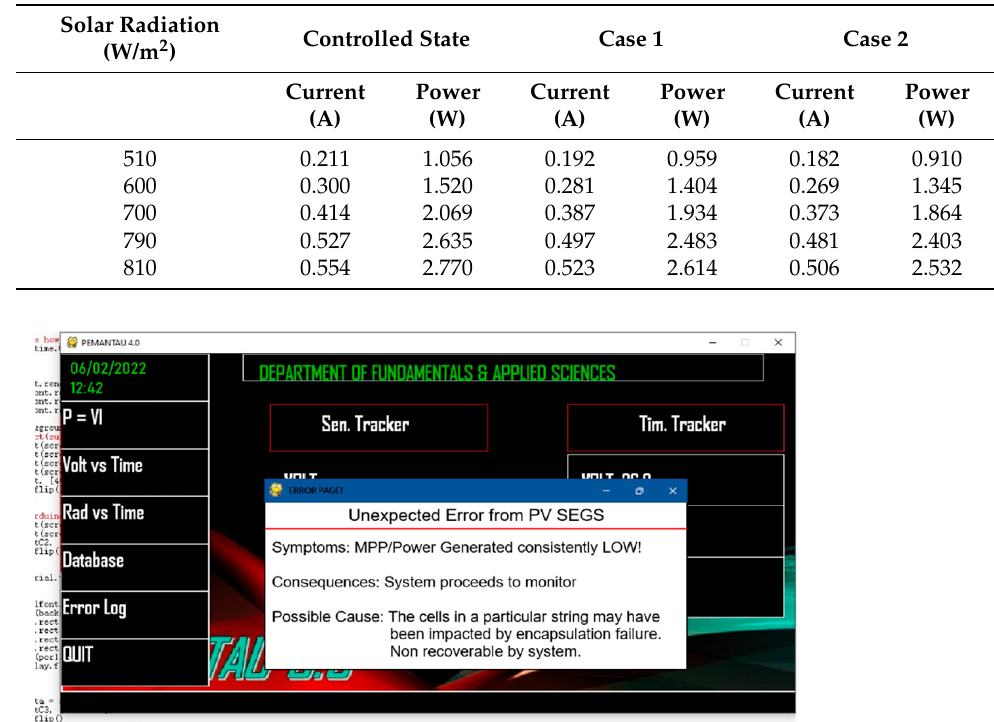
Table 5. Comparison of the current and power output of the PV miniature system for the three conditions at different solar radiations.